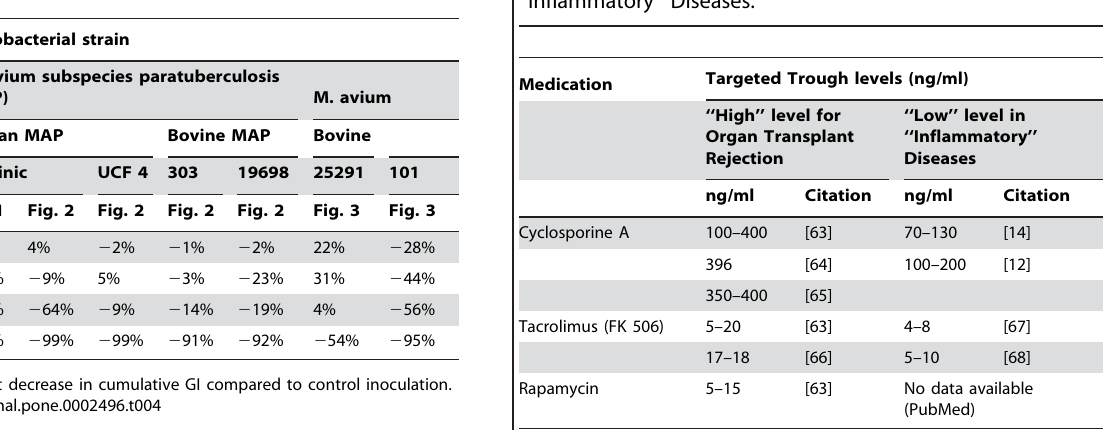
Table 7. Immunosuppressant Therapeutic Trough levels used in ‘‘High’’ dose for transplantation rejection and ‘‘Low’’ dose in ‘‘Inflammatory’’